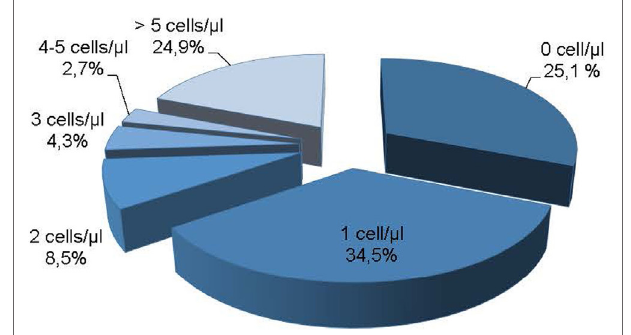
FigUre 7 | Samples grouped according to cellularity.